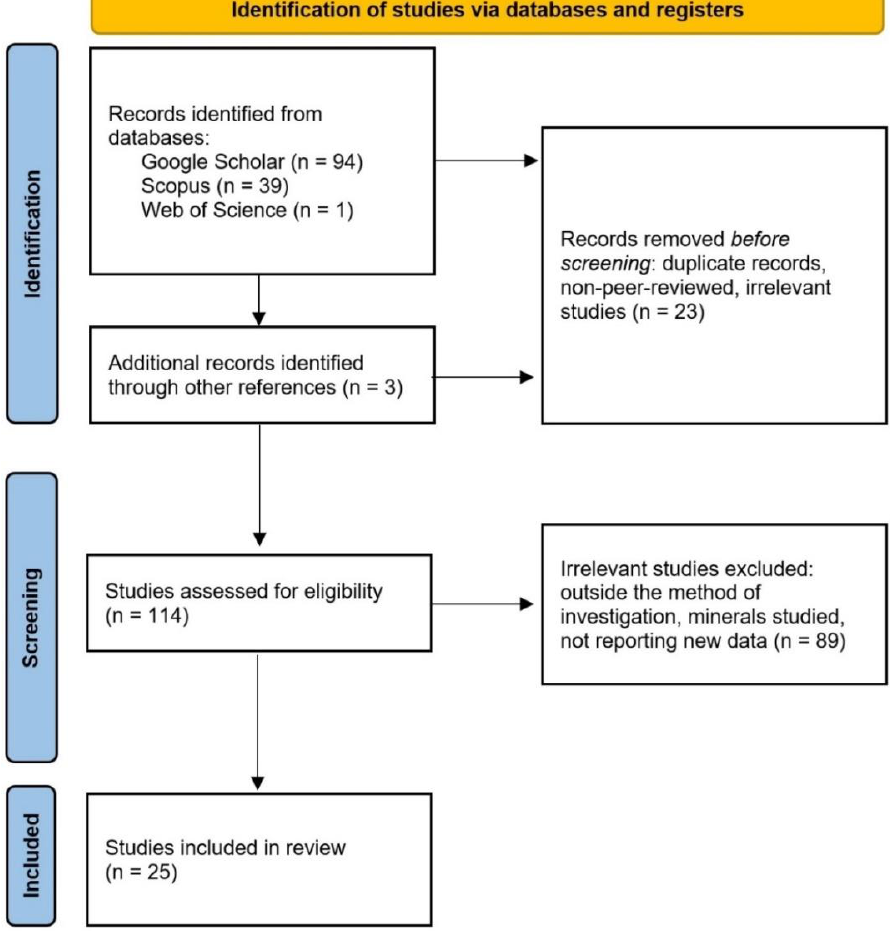
Figure 1. The systematic review protocol to obtain records for synthesis was conducted according to PRISMA guidelines, adapted from [35]. See PRISMA checklist in Supplementary Table S1. Combination of keywords A and B are shown below in Table 1. The search was carried out on 5 April 2022.